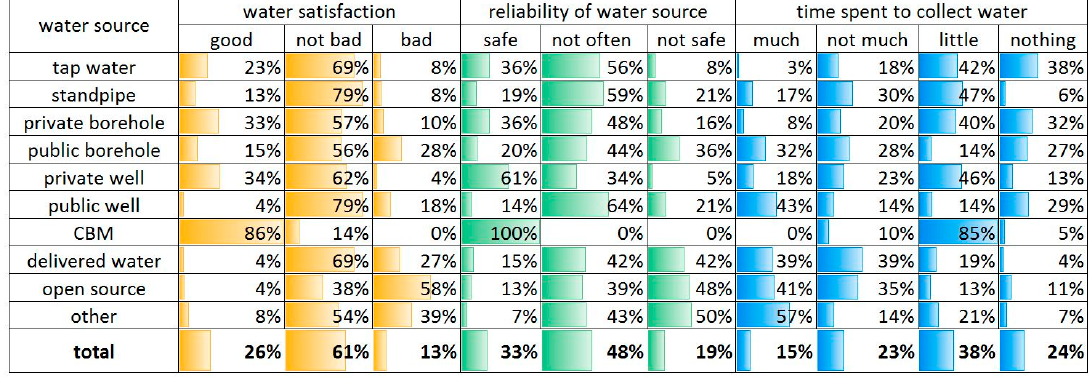
Figure 3. Perceived characteristics of the water source.